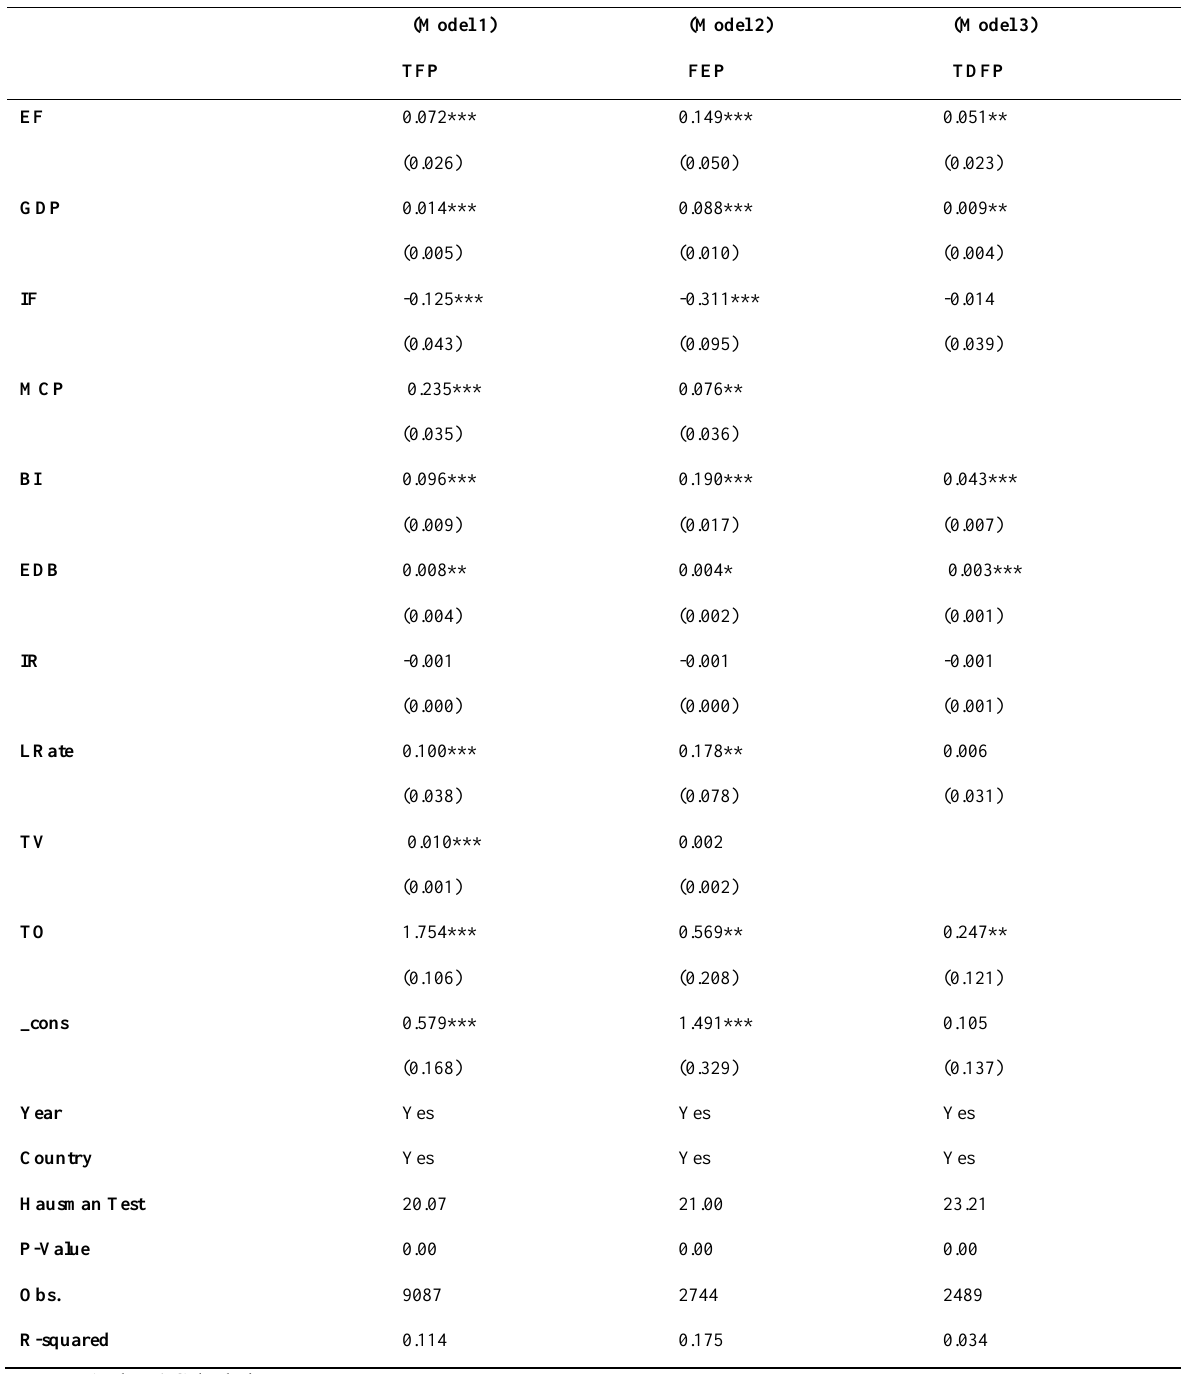
Table 4: Regression results of Foreign Equity Portfolio Investment and Economic